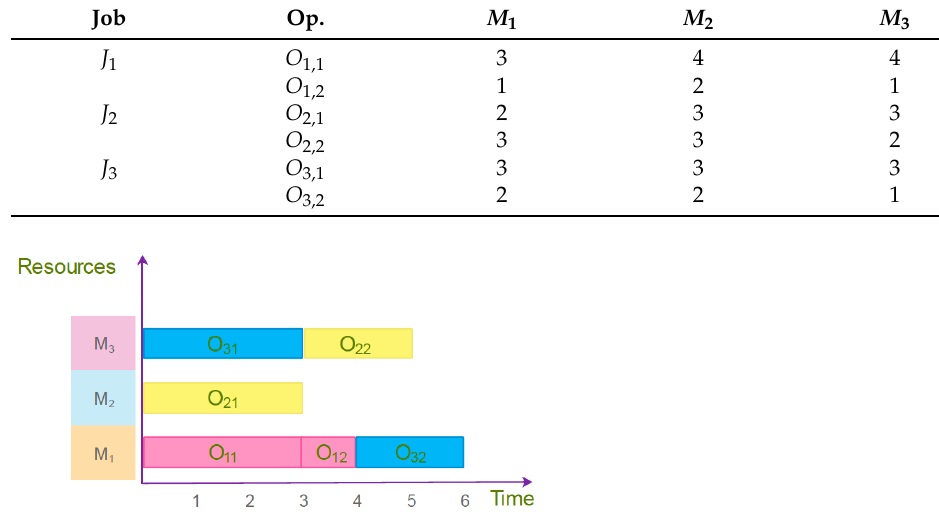
Figure 1. Gantt diagram of one possible solution for the FJSSP in Table